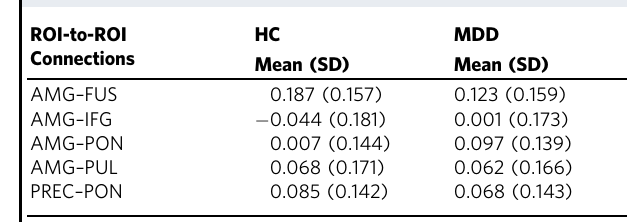
Table 3 Resting-state functional connectivity in HC and MDD patients, Study